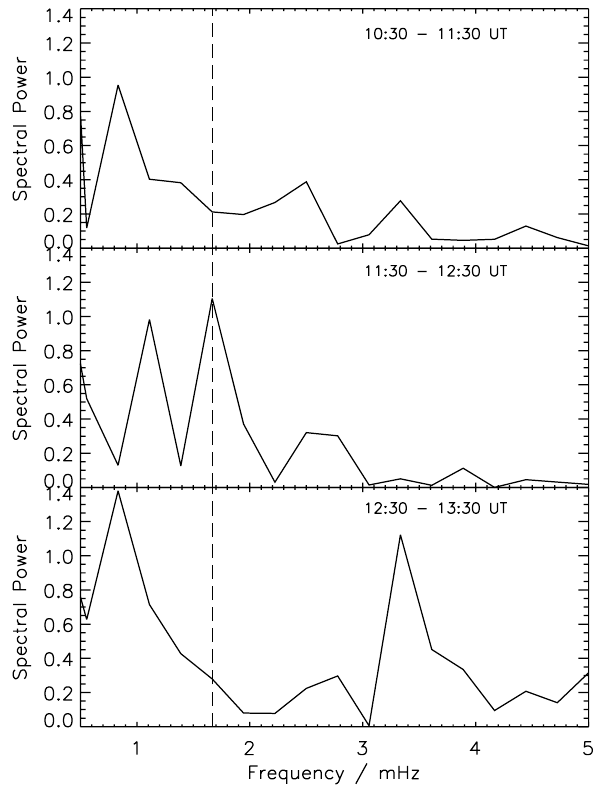
Fig. 6. Fourier analysis of three hour-long segments of magnetic Figure 6 field magnitude data from Cluster-2 FGM, corresponding to before, during and after the SPEAR heating interval. The vertical dashed lines mark the 1.67mHz modulation frequency.